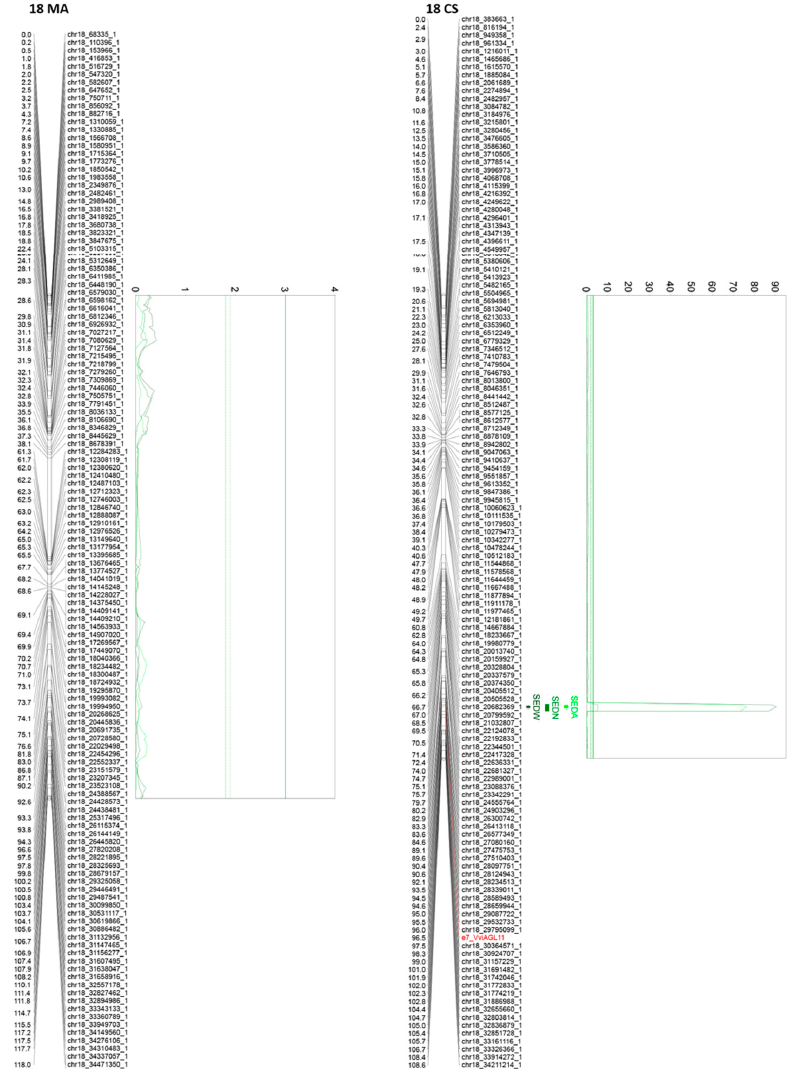
Figure 4. Principal QTLs detected in chromosome 18 for seedlessness subtraits SEDW, SEDN, and SEDA in the MA × CS experimental population. SEDW: seed fresh weight per berry; SEDN: number of seeds per berry; SEDA: average fresh weight of one seed. 1-LOD and 2-LOD support confidence intervals were drawn. Thresholds for suggestive (dashed lines) or significant (continues lines) QTLs were established by a permutation test with 10,000 iterations. Both parental maps were represented. MA: Muscat of Alexandria; CS: Crimson Seedless.